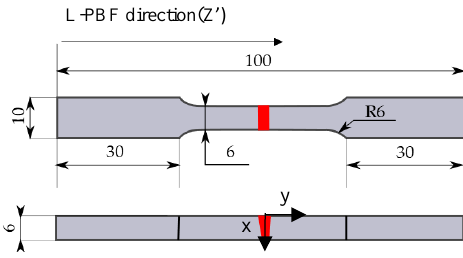
Figure 5: Front and top views of the tensile test sample fabricated as per ASTM E8